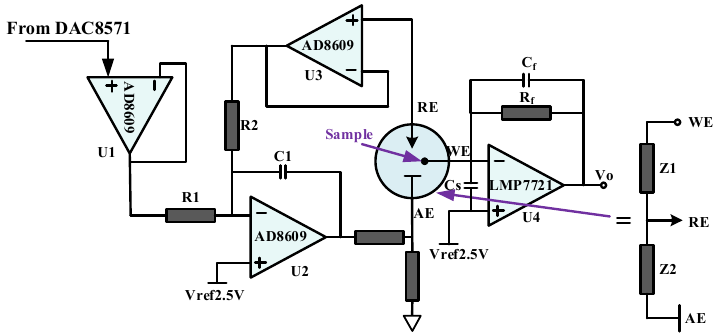
Figure 4. Circuit of control amplifier.